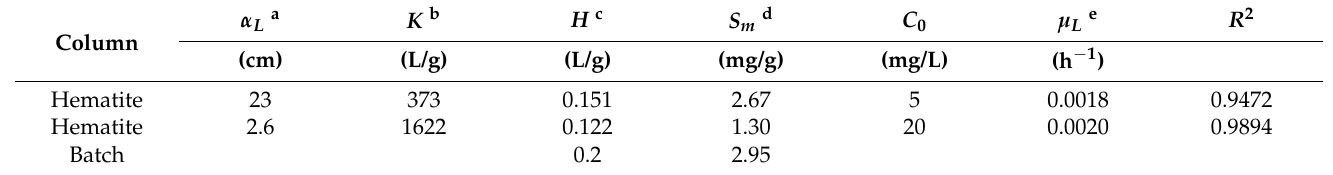
Table 2. Parameter values obtained from HYDRUS-1D for Cr (VI) transport through columns packed with hematite in different concentrations.